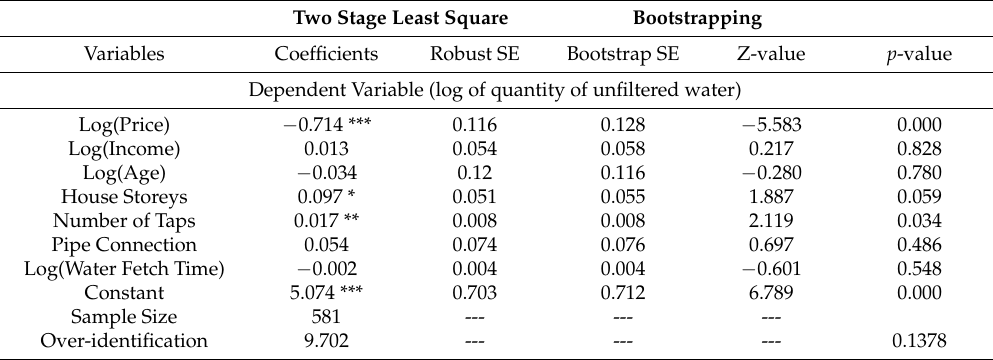
Table 5. Two-stage least square rstimation of residential water demand (unfiltered